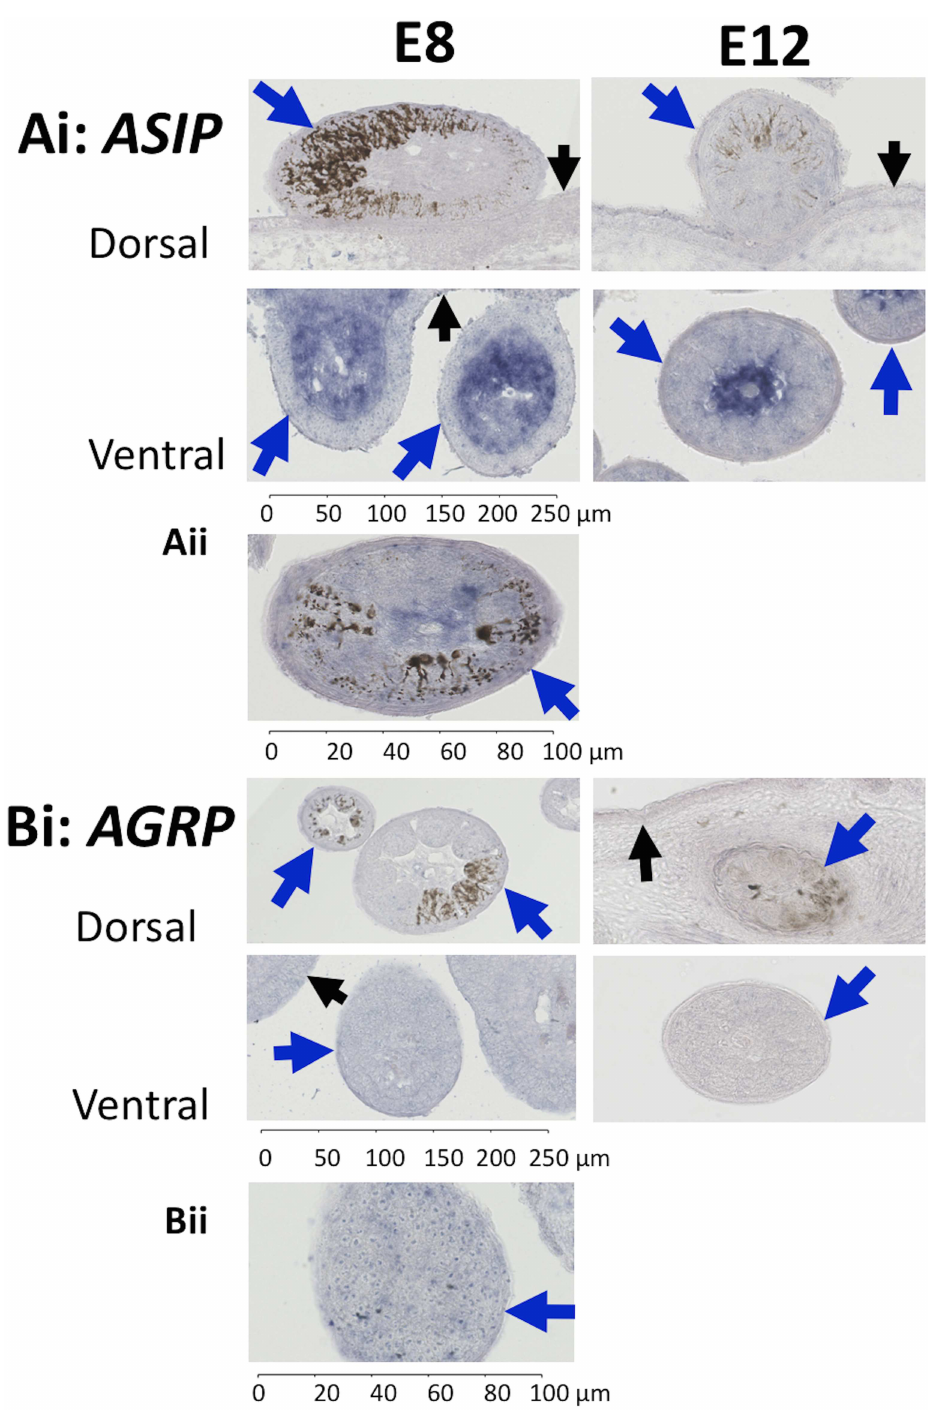
Fig 4. In situ hybridization results for ASIP and AGRP in quail feather follicles at E8 and E12. The epidermis is labelledwith a small black arrow and feather follicleswith a large blue arrow. Ai) ASIP is expressedin the dermalpulp of ventral feather follicles in E8 and E12 embryos, but is not visibleon the dorsal surface. Bi) AGRP was not expressedin the feather follicles in early or late development, either ventrally or dorsally.Aii) ASIP expressionin a feather follicle with eumelaninon the flank of a Japanesequail embryo at E12. In some feather follicles in the flank or on the wing of E12 embryos ASIP expressionwas observedwith eumelanin pigmentation. Bii). Representative transcription of AGRP in ventral developingfeather folliclesin E8 Japanesequail embryos. Similar stainingwas found in feather follicleson the dorsalsurface of quail E8, as well as both the ventral and dorsal surface of quail E12, and the